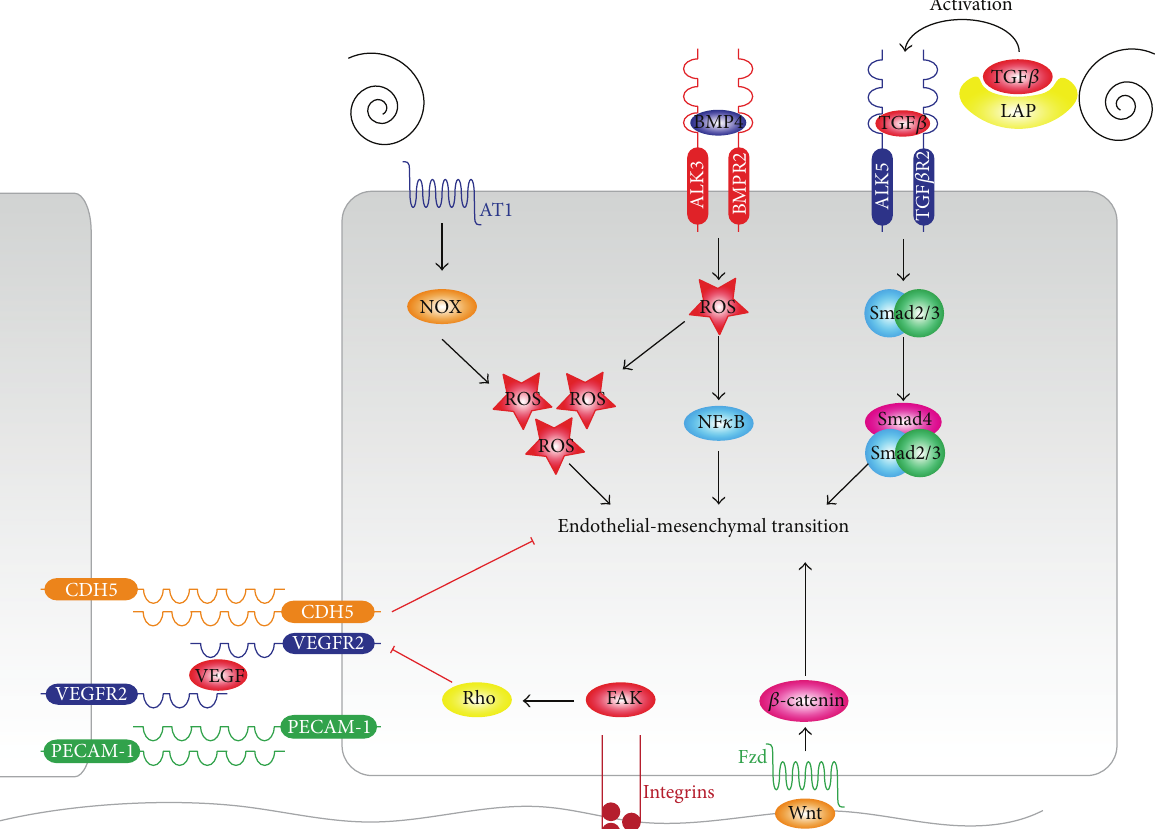
Figure 4: Disturbed shear stress and high cyclic strain signaling in endothelial-mesenchymal transition. Disturbed shear stress induces EndMT through several mechanisms. Disturbed shear stress activates latent TGF 𝛽 by liberating it from LAP, after which TGF 𝛽 can induce Smad2/3 signaling. Disturbed shear stress induces the expression of BMP4 which causes ROS formation and the activity of NF 𝜅 B. Lastly, disturbedshearstressinducesNOXandXOactivityresultinginthegenerationofROS.AllthesesignalingintermediatesculminateinEndMT. Increased cyclic strain ( > 10%) induces the FAK-dependent activation of Rho-kinases. Rho activity causes the translocation of VE-Cadherin from the cell membrane into cytoplasmic vesicles and causes a reduction in endothelial cell-cell contacts. Cyclic strain-dependent Wnt- 𝛽 - catenin activity induces EndMT in part by the induction of Snail and Slug and the further activation of Rho activity.